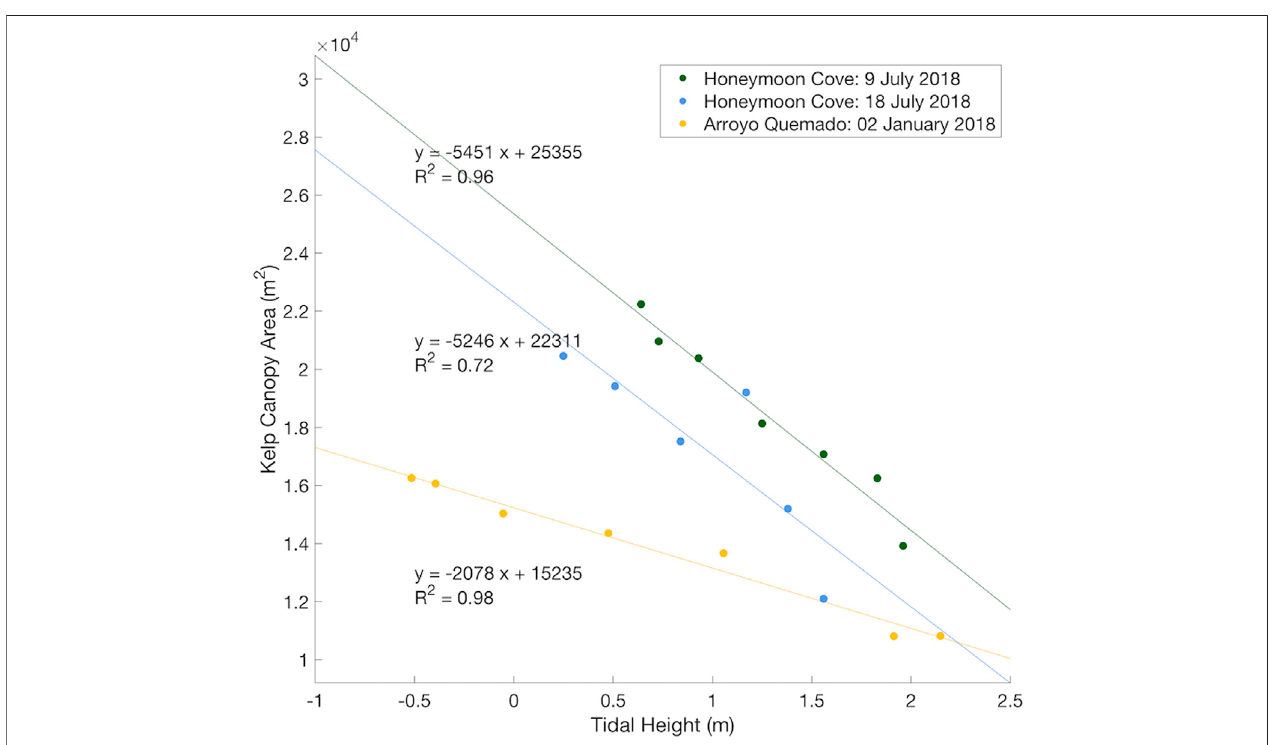
FIGURE8| RegressionanalysisbetweenkelpcanopyareaandtidalheightforeachtidalsurveycompletedatHoneymoonCove(n (cid:2) 7,n (cid:2) 6)andArroyoQuemado (n (cid:2) 7).